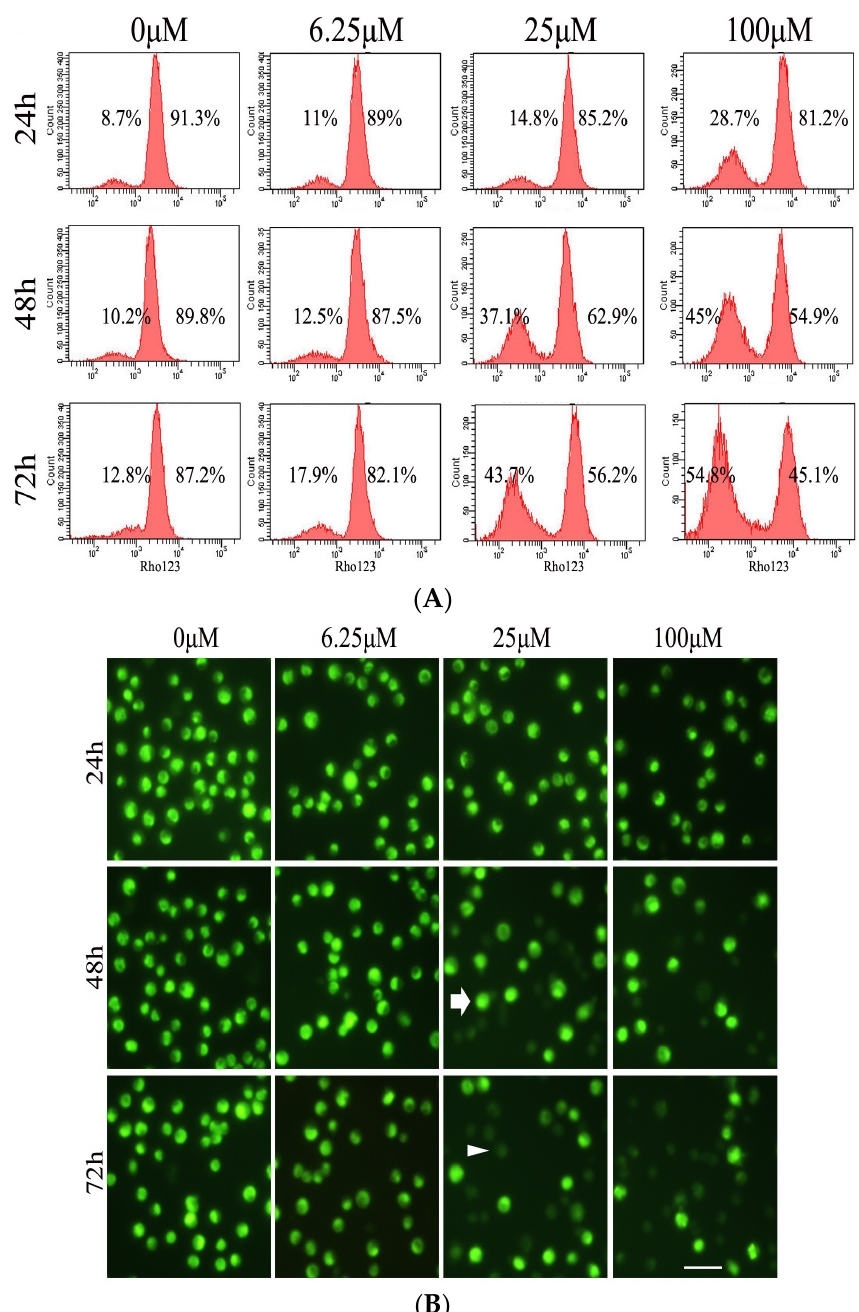
Figure 3. Effects of luteoloside on the mitochondria of Hela cells. ( A ) Hela cells were treated with 0, 6.25, 25, and 100 μM luteoloside for 24, 48, or 72 h, and then harvested and stained with Rhodamine 123, followed by flow cytometric analysis. The data left and right are the percentages of the cells with low and high fluorescence intensity respectively; ( B ) The cells were treated as described in ( A ) and observed under a fluorescence microscope. The arrow and arrowhead indicate the cells with high and low fluorescence intensity respectively. Bar = 25 μm.